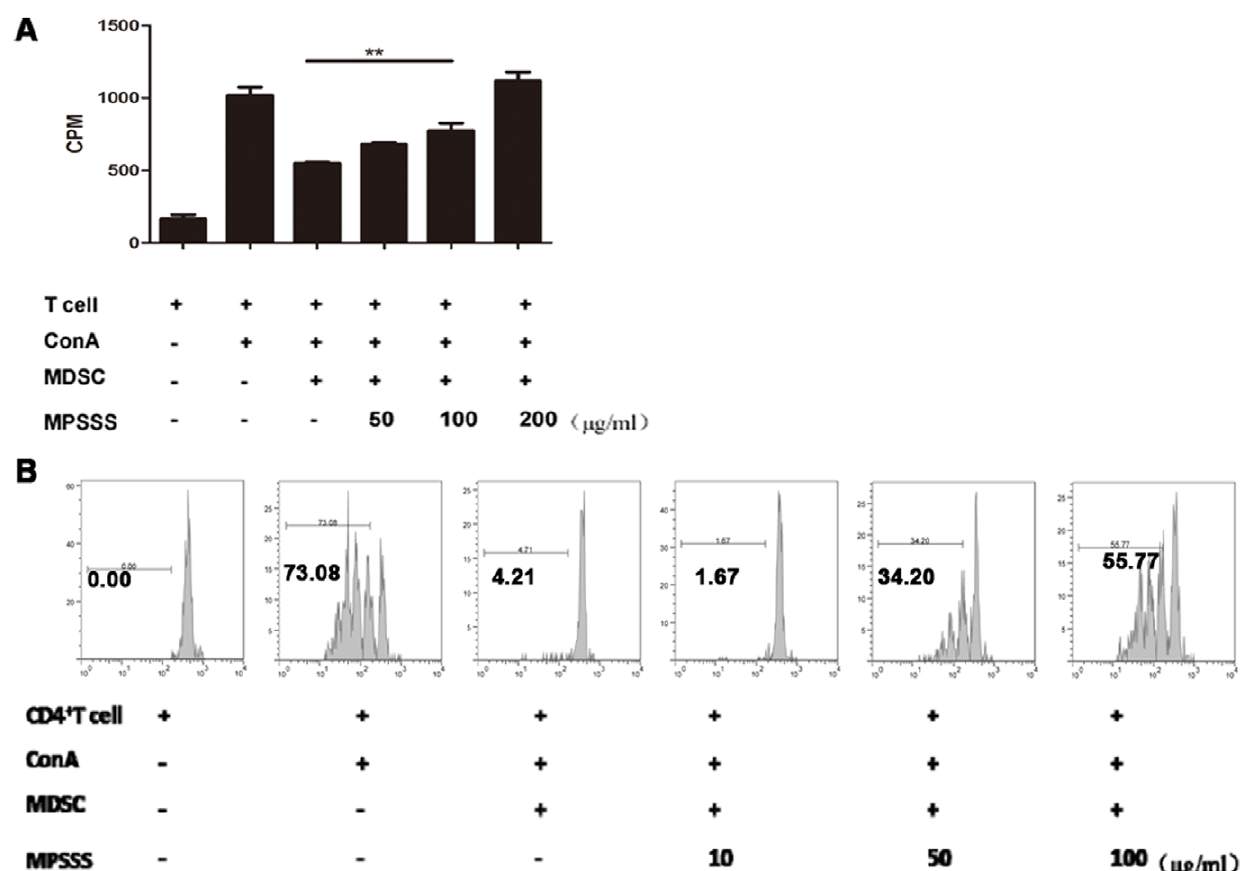
Figure 4. MPSSS promoted functional recovery of splenocytes following MDSC-induced suppression. (A) [ 3 H]-thymidine or (B) CFSE- labeled splenocytes were co-cultured with purified MDSCs isolated from McgR32 tumor-bearing mice and stimulated with or without ConA or MPSSS as indicated. Results were presented as mean 6 SD of triplicate samples from one representative experiment and were analyzed by one-way ANOVA. Comparisons between these groups were performed using the S-N-K method. ** P , 0.01.